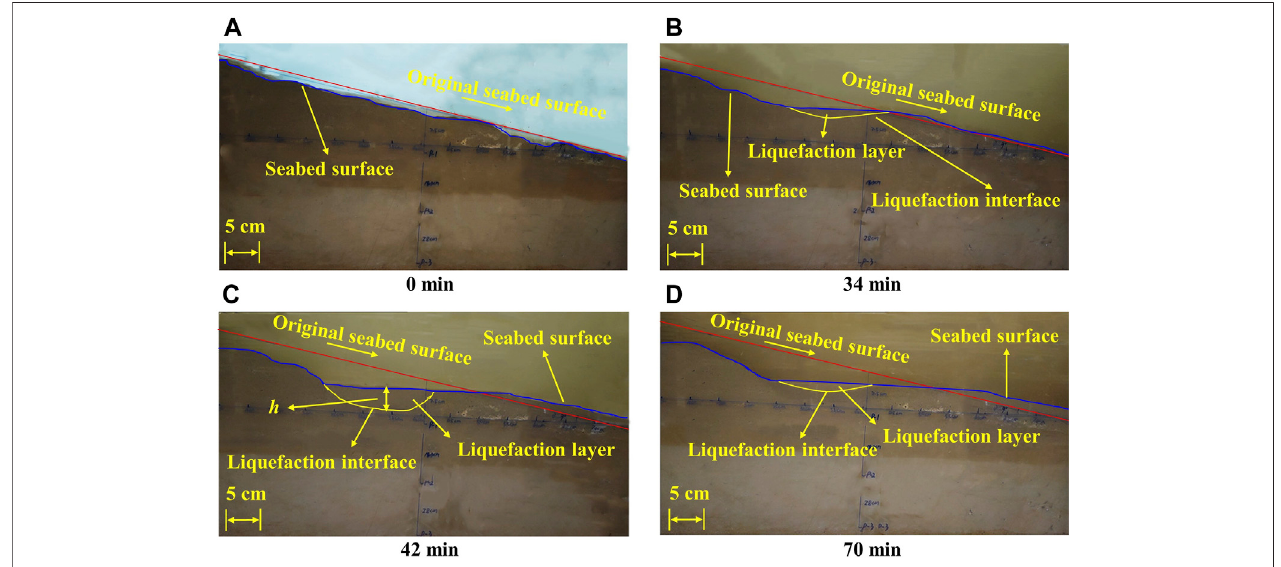
FIGURE4| Changesofseabedsurfaceandevolutionofliquefactioninterfaceatdifferenttimes. (A - D) arethepositionsofseabedsurfaceandliquefactioninterface at 0, 34, 42 and 70 min, respectively, where h is the liquefaction depth.